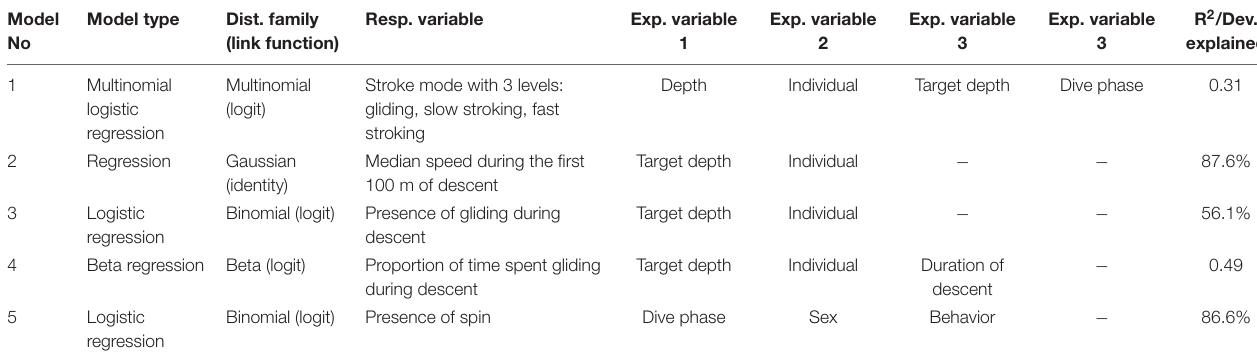
TABLE 3 | Summary of the models with the best